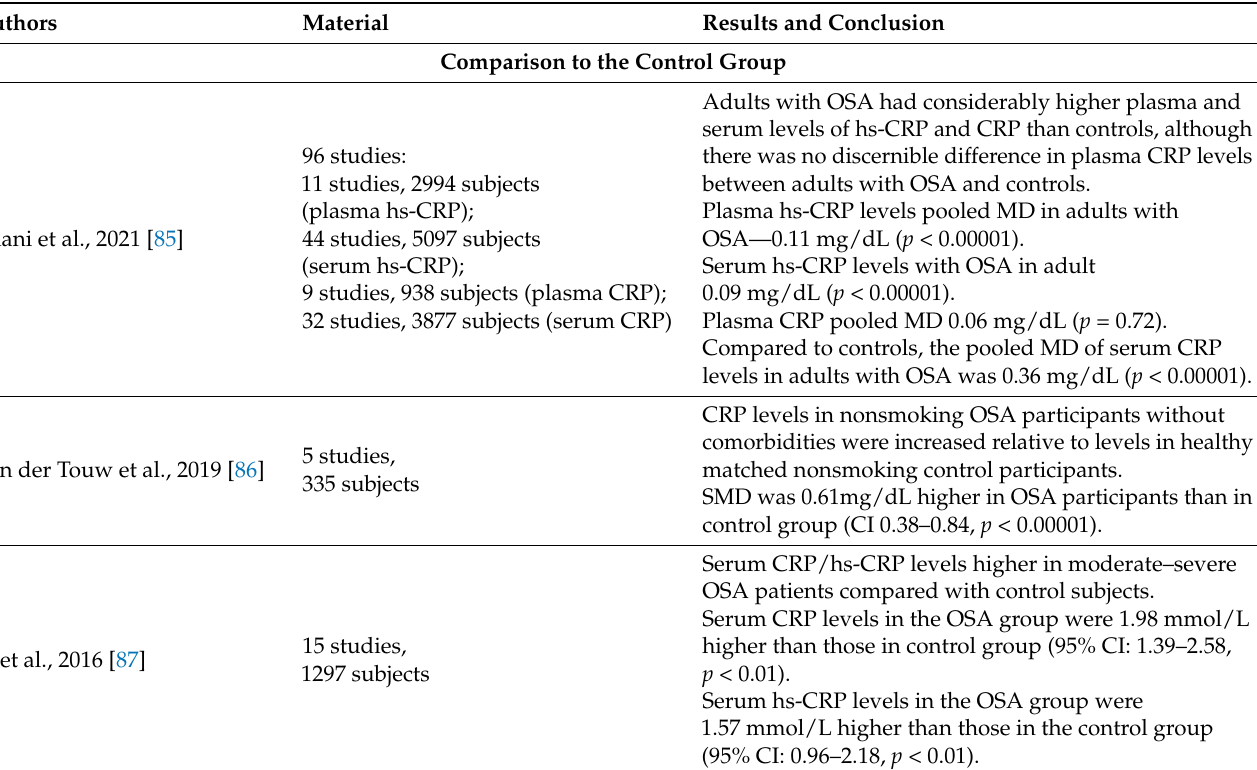
Table 3. Meta-analyses of CRP studies in OSA